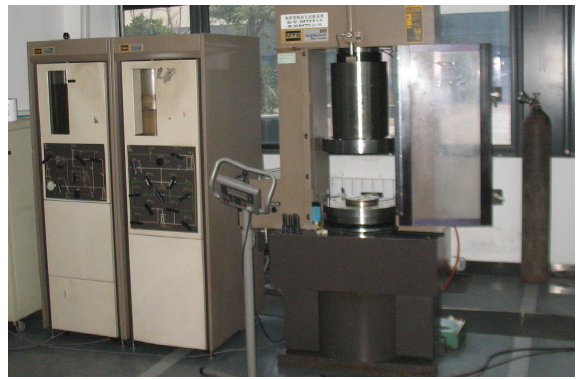
Figure 3: MTS815.02 electrohydraulic servo rock mechanics test